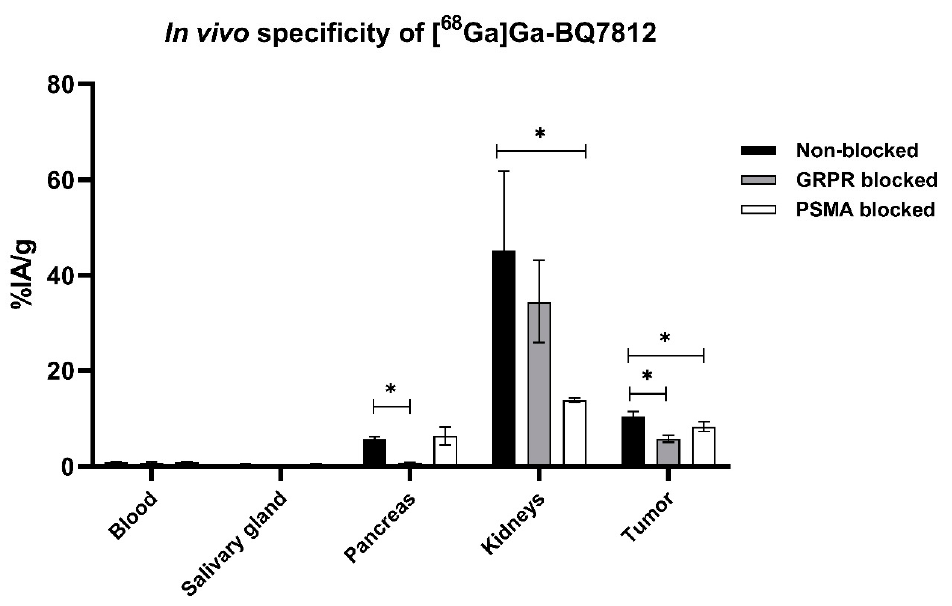
Figure 4. In vivo binding specificity of [ 68 Ga]Ga-BQ7812 towards PSMA and GRPR at 1 h pi in PC3-pip tumour-bearing mice. Co-injection of non-labelled NOTA-PEG 2 -RM26 (5 nmol/animal) or non-labelled PSMA-11 (5 nmol/animal) to block GRPR and PSMA respectively. Statistical anal- ysis was done using one-way ANOVA with Bonferroni’s test corrected for multiple comparisons. * Statistically significant ( p < 0.05) difference in organ